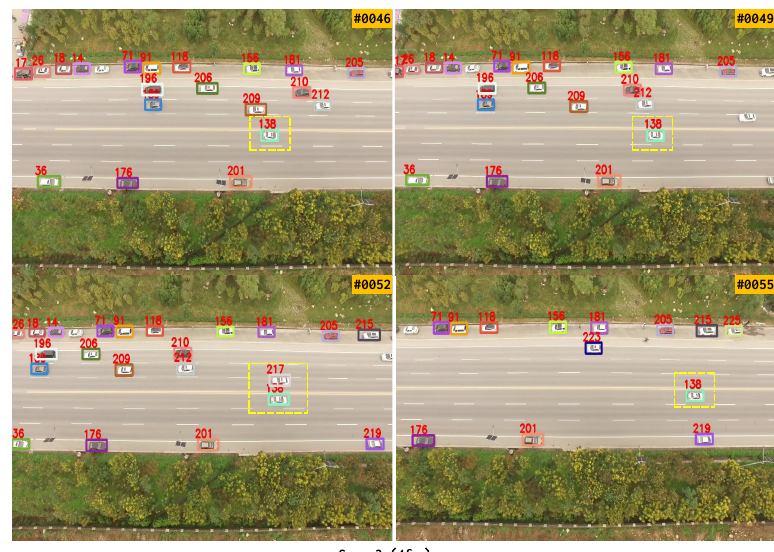
Figure 9. Tracking results of four tracking algorithms in Scene 3 with 4 fps frame rate, enlarged to show tracking effect more clearly. This set of results mainly show that the algorithm of this paper could track high-speed moving vehicles well when acquisition frame rate was only 4 frames on the